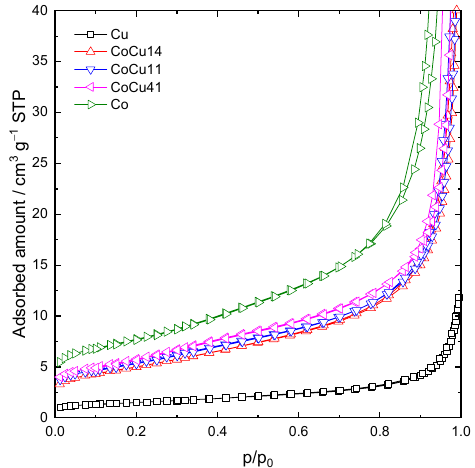
Figure 3. Nitrogen adsorption isotherms of the Co-Cu oxide catalysts.